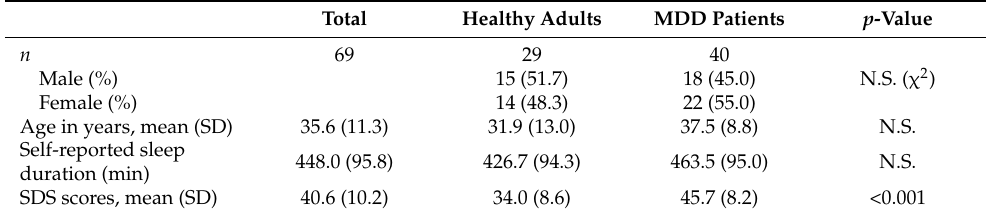
Table 2. Demographic and clinical characteristics of the study